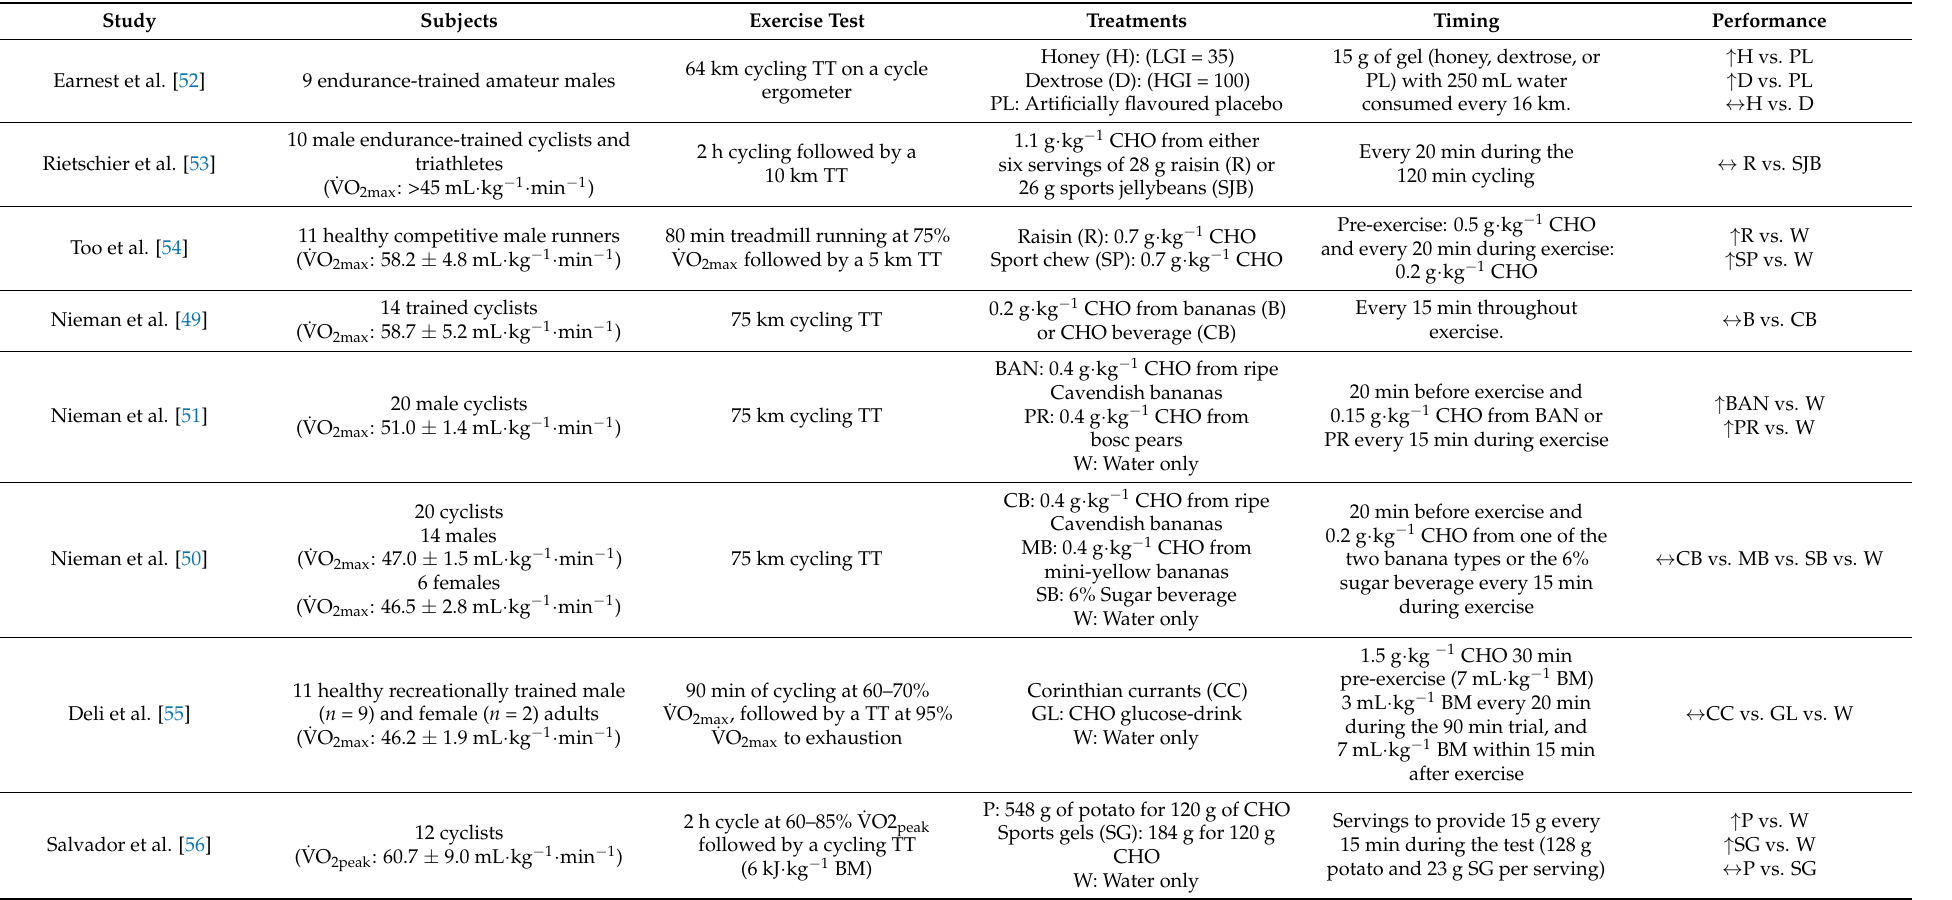
Table 2. Summary of studies exploring the effects of CHO foods ingestion during exercise on